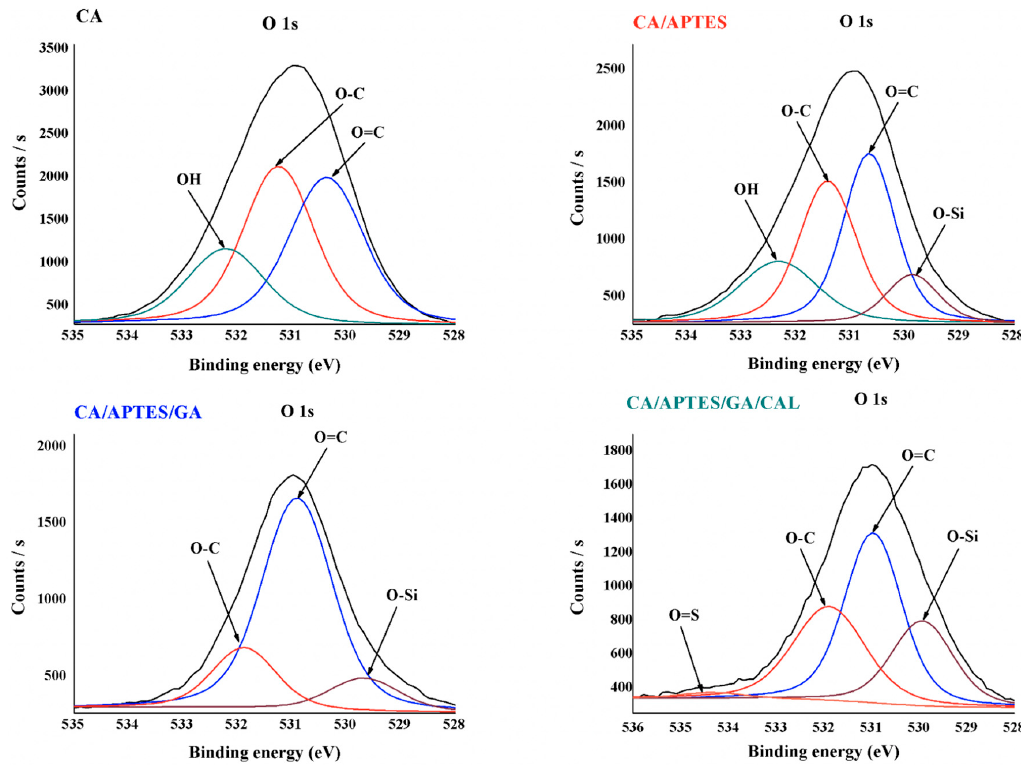
Figure 7. The fitted O 1s spectra for synthesized samples.